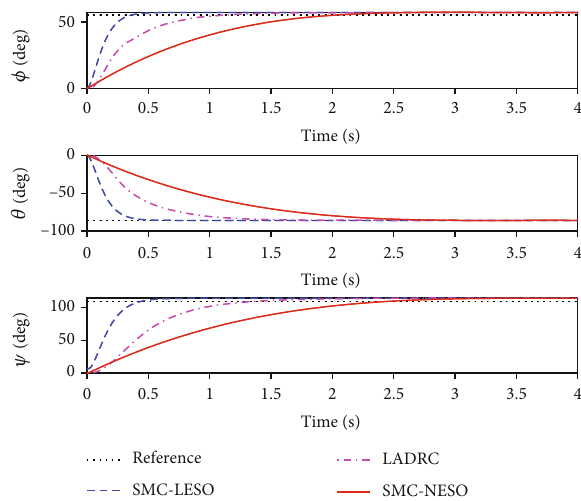
Figure 5: Simulation results of Case